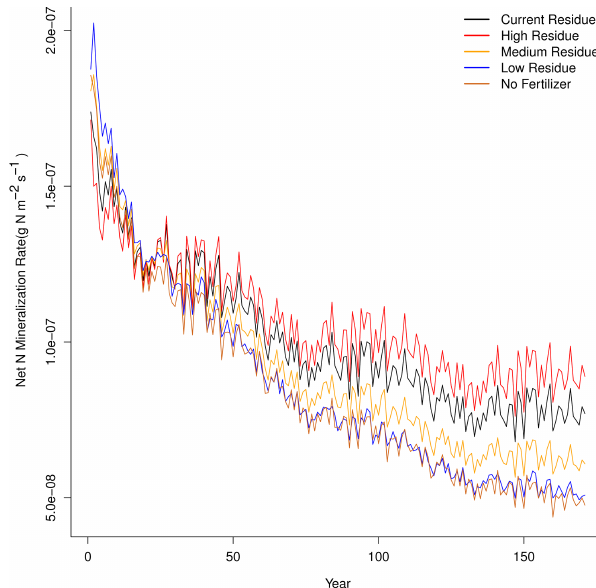
Figure 8. The effect of agricultural land management change on crop annual average nitrogen